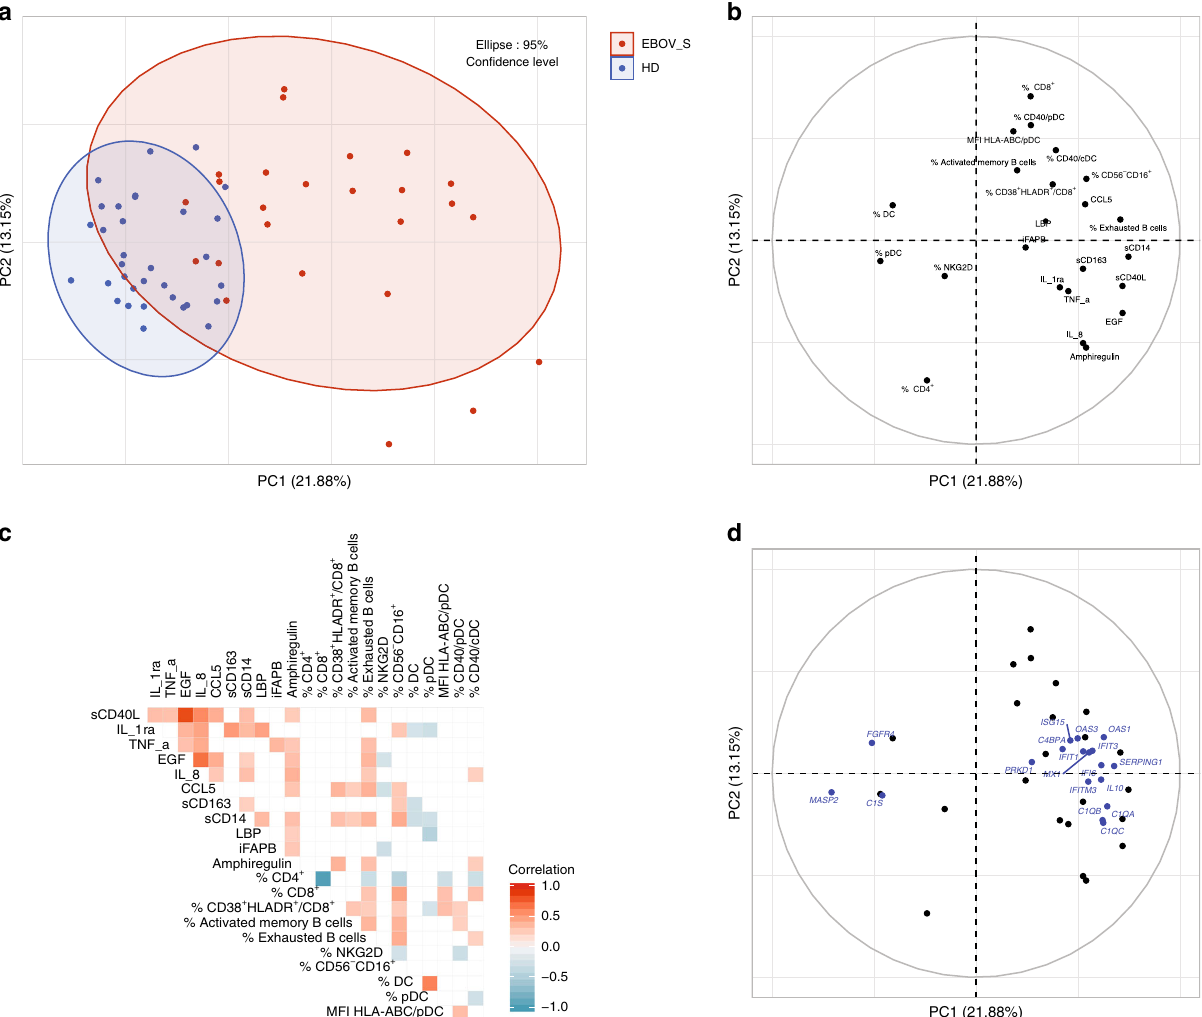
Fig. 5 Persistence of innate immunity dysfunction in EBOV_S. Unsupervised principal component analysis of serum-soluble mediators and cell phenotypic data, including n = 26 EBOV_S and n = 33 HDs. EBOV_S are indicated in red and HDs in blue ( a ). Variables used for the construction of the components ( b ). Spearman ’ s correlation matrix between serum-soluble mediators and cell phenotypes from n = 39 HDs and n = 34 EBOV_S. Colors indicated Spearman ’ s correlation coef fi cient. Only signi fi cant correlations ( p < 0.05) are represented (unadjusted for test multiplicity) ( c ). Unsupervised PCA including genes (blue) from the main pathways associated with differentially expressed genes in EBOV_S and HDs, including IFN signaling, the complement system and PRR signaling pathways (